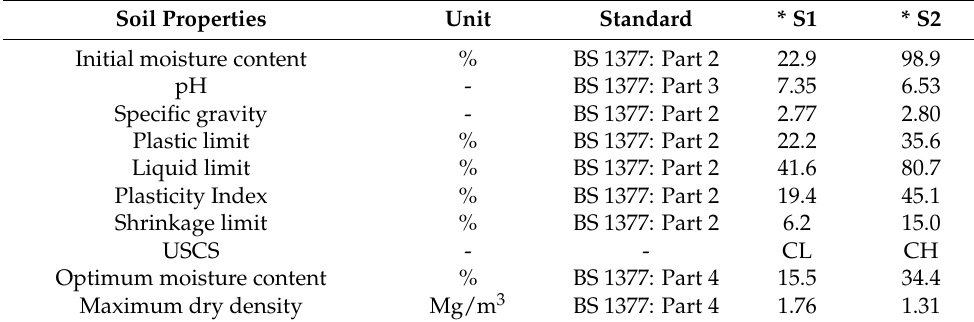
Table 1. Geotechnical characteristics of untreated soils.